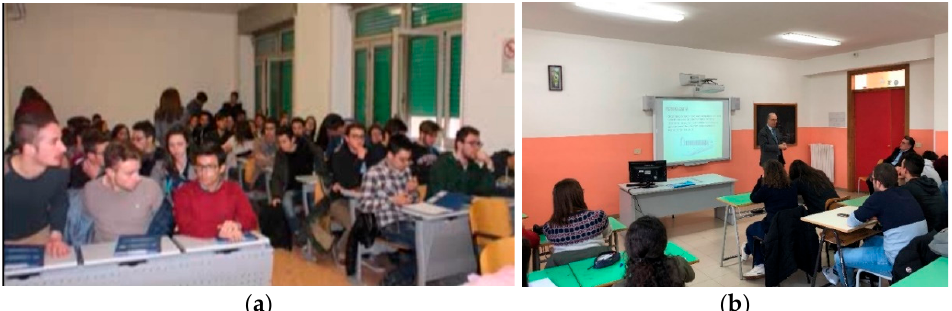
Figure 2. Students and teachers of IS Ae in the university classrooms ( a ) and in those of the school ( b ) participate, within the framework of the didactic laboratory activities (Action “a” of the PNG), in lessons on the selected geosciences topics and in the exercises of map reading (year 2017).